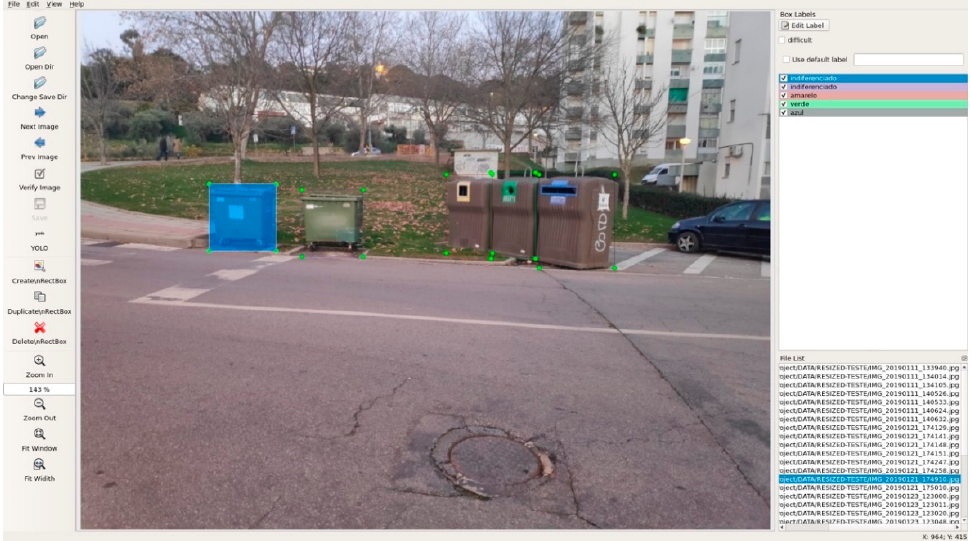
Figure 1. The image labeling software example.